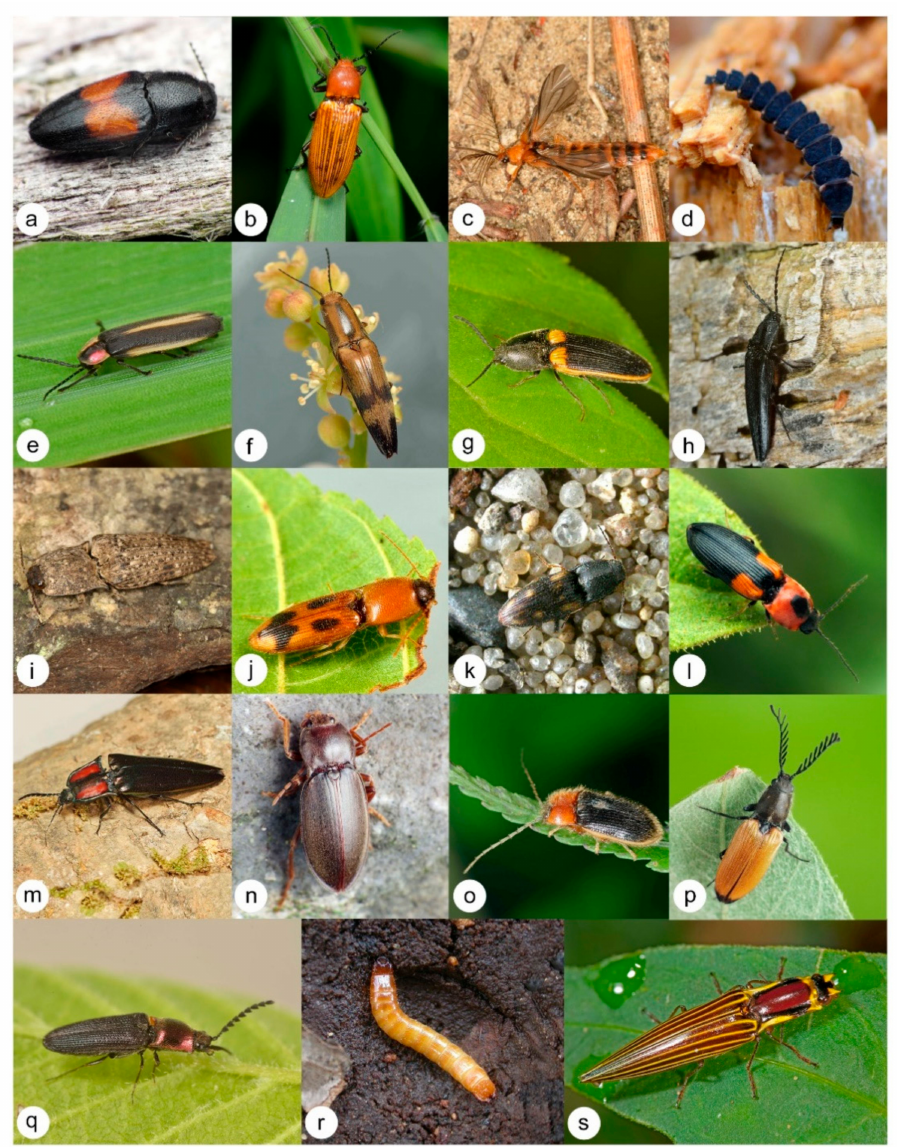
Figure 1. Representatives of the subfamilies of Elateridae and the lampyroid clade ( a ) Drapetes mordelloides (Host, 1789) (Lissominae; image: T. N é meth), ( b ) Hemiops sp. (Hemiopinae; image: S. A. Marshall), ( c ) Phengodes sp. (Phengodidae; image: S. A. Marshall), ( d ) Lampyris sp. (Lampyridae; image: A. Prosvirov), ( e ) Lampyridae (image: S. A. Marshall), ( f ) Aphanopenthes vanus (Germar, 1844) (Elaterinae; image: S. A. Marshall), ( g ) Ampedus oblessus (Say, 1833) (Elaterinae; image: S. A. Marshall), ( h ) Tibionema sp. (Pityobiinae; image: S. A. Marshall), ( i ) Cryptalaus sp. (Agrypninae; image: F. Trnka), ( j ) Aeolus sp. (Agrypninae; image: S. A. Marshall), ( k ) Negastrius pulchellus (Linnaeus, 1761) (Negastriinae; image: www.elateridae.com accessed on 8 January 2021), ( l ) Cardiophorus kindermanni Cand è ze, 1860 (Cardiophorinae; image: T. N é meth), ( m ) Campsosternus sp. (Dendrometrinae; image: S. A. Marshall), ( n ) Dima pelikani Mertlik, N é meth and Kundrata, 2017 (Dendrometrinae; image: T. N é meth), ( o ) Penia cinctipennis Fleutiaux, 1936 (Dendrometrinae; image: S. A. Marshall), ( p ) Anos- tirus castaneus (Linnaeus, 1758) (Dendrometrinae; image: T. N é meth), ( q ) Limonius aurifer (LeConte, 1853) (Dendrometrinae; image: S. A. Marshall), ( r ) Gambrinus violaceus (Müller, 1821) (Dendrometri- nae; image: www.elateridae.com accessed on 8 January 2021), ( s ) Semiotus bispinus Cand è ze, 1874 (Dendrometrinae; image: S. A.